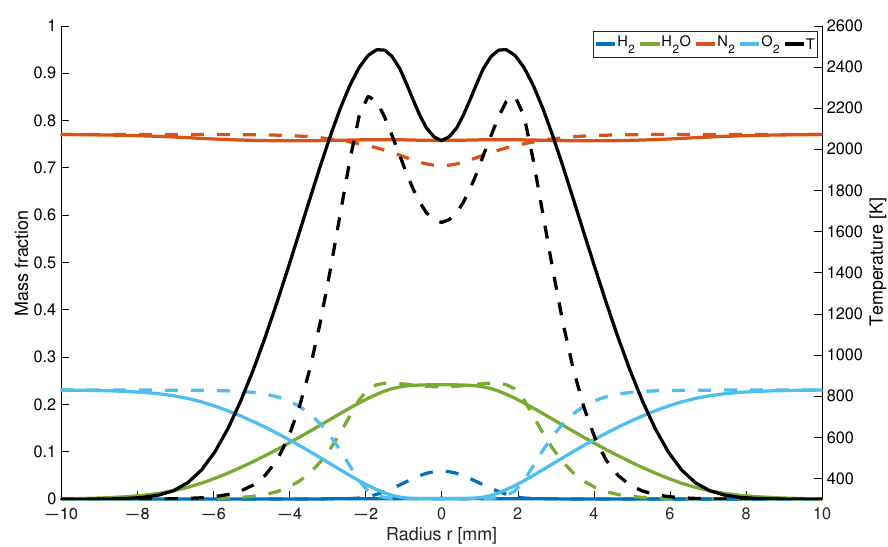
Figure 4. Temperature and mass fraction at a height of 5 mm; solid line: with differential diffusion, dashed line without differential diffusion.